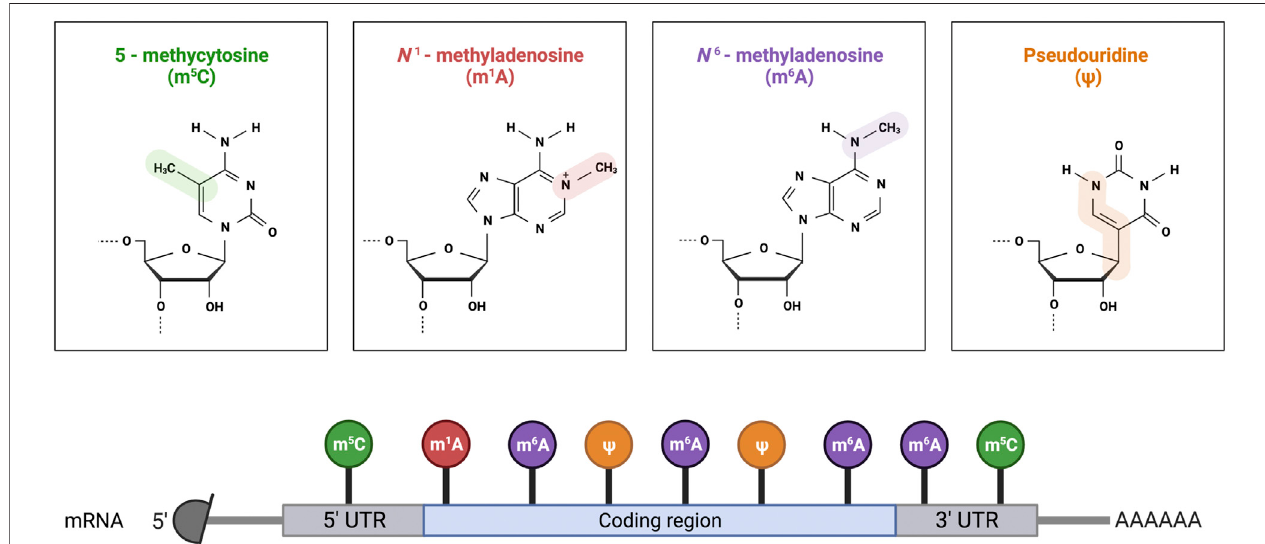
FIGURE 2 | Schematic representation of the common RNA modi fi cations in mRNA. Created with Biorender.